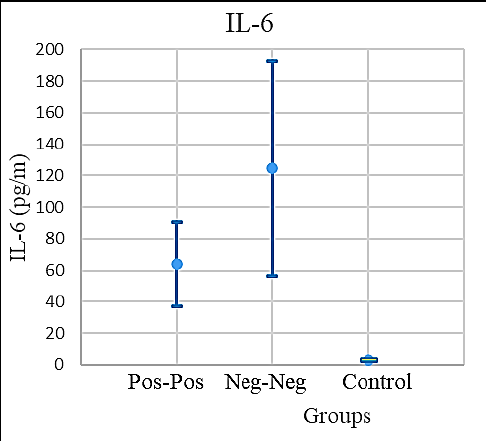
Figure 5. The IL-6 mean levels and the confidence intervals for COVID-positive, COVID-free patients, and the control groups.